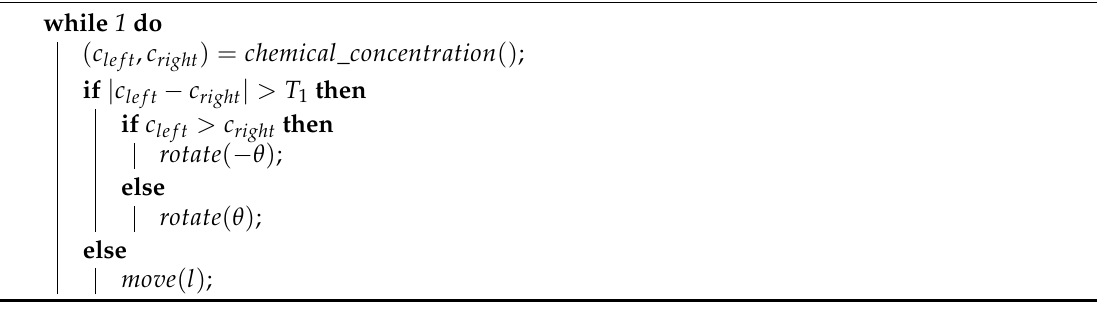
Algorithm 3: Pseudocode of the first control strategy proposed by Grasso et al. [14].